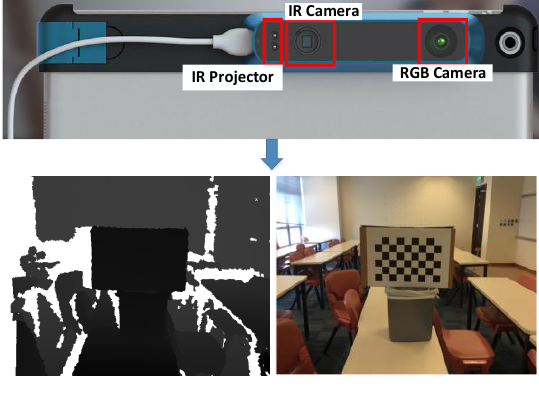
Figure 1. (Top) The hardware scheme of the RGB-D sensor, (bottom left) the acquired depth image, and (bottom right) the acquired RGB